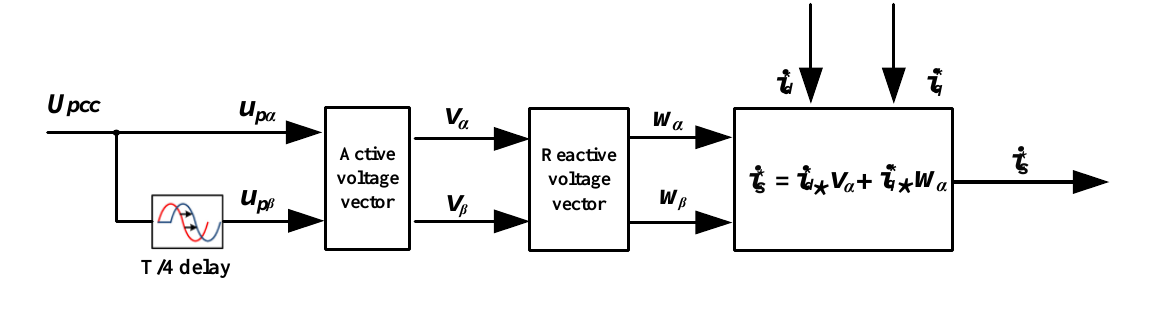
Figure 5. Control model in αβ frames.